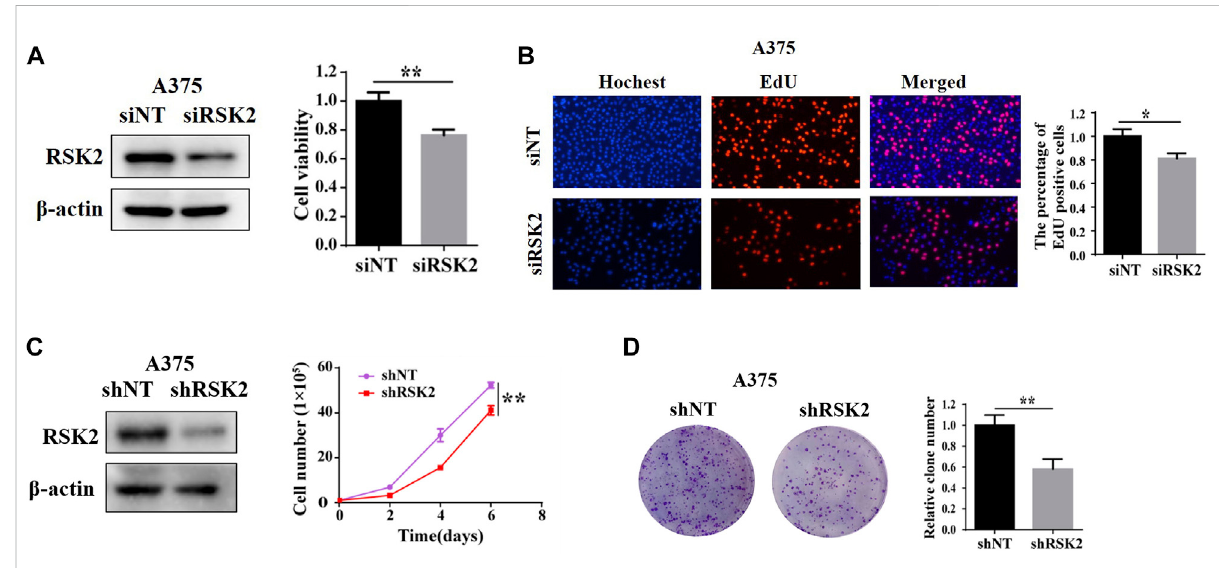
RSK2 promotesmelanoma cell proliferation. (A) A375 cells weretransfectedwith siNT and siRSK2, theexpressionofRSK2 proteinwas analyzed byWesternblotandcellviabilitywasmeasuredusingCCK-8analysis. (B) Therelativequanti fi cationofEdU-positivecellswasexhibited. (C) A375cells weretransfectedwithshNTandshRSK2,theexpressionofRSK2proteinwasanalyzedbyWesternblotandthegrowthcurvewasdetermined. (D) The quanti fi cation of relative clone number was exhibited. p p < 0.05, pp p < 0.01 vs. the Con